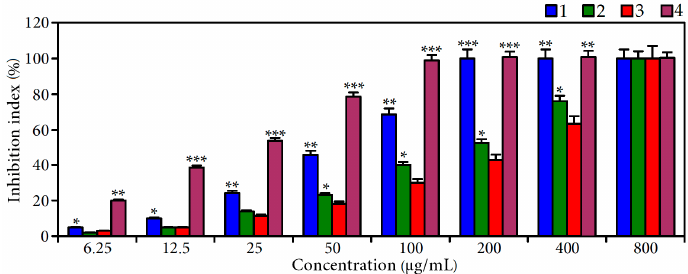
Figure 3. α -Glucosidase inhibition of C. palustre extracts A ( 1 ); and B ( 2 ); acarbose ( 3 ); and agrimoniin ( 4 ). Values shown are mean ± SD ( n = 3). Asterisks indicate statistically significant differences from acarbose (* p < 0.05; ** p < 0.01; *** p <